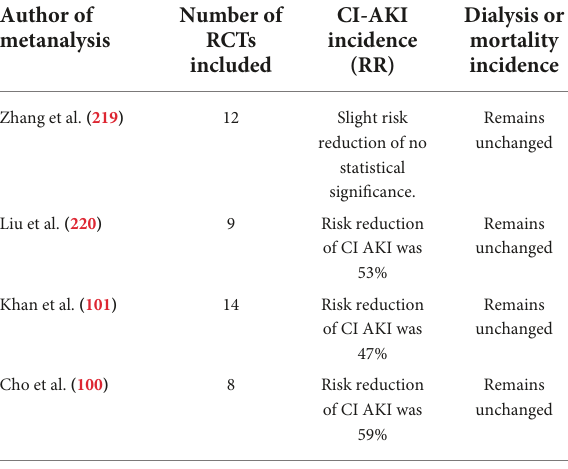
TABLE 9 Comparing meta-analysis of statin therapy as prevention method for